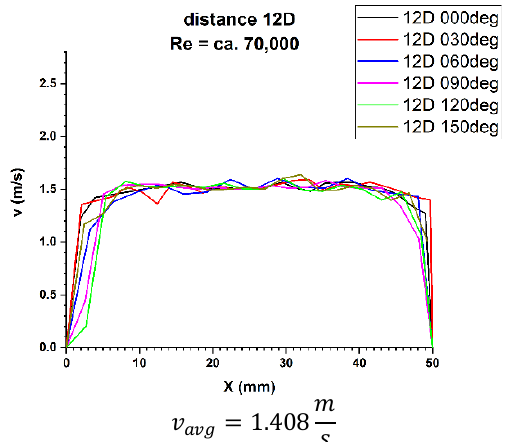
Figure 25. Velocity profiles at a distance 12D from the disturbance with marked cross-sections for Re ≅ 70,000-The LDA measurement taken in the ultrasound wave path.